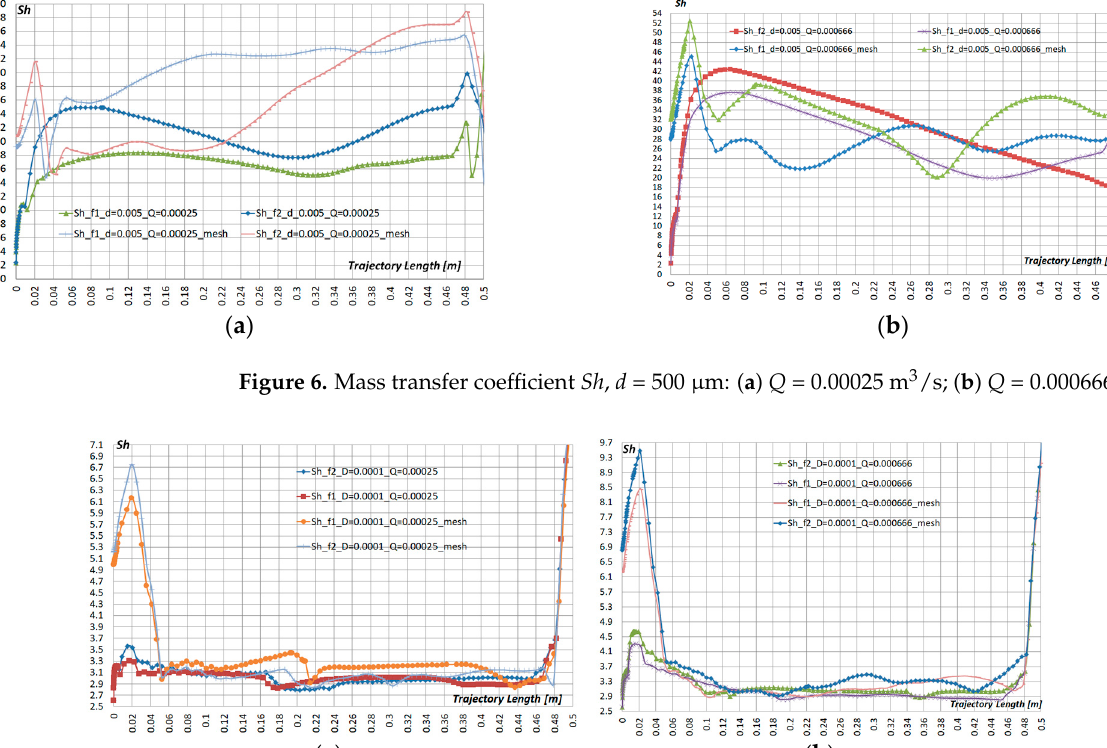
Figure 7. Mass transfer coefficient Sh , d = 100 µm: ( a ) Q = 0.00025 m 3 /s; ( b ) Q = 0.000666 m 3 /s. The average values of the mass transfer coefficient Sh are summarized in Table 1.